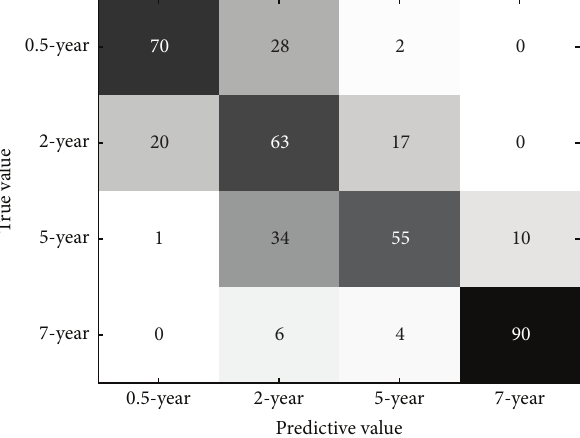
Figure 16: RBF neural network confusion matrix for testing sam-